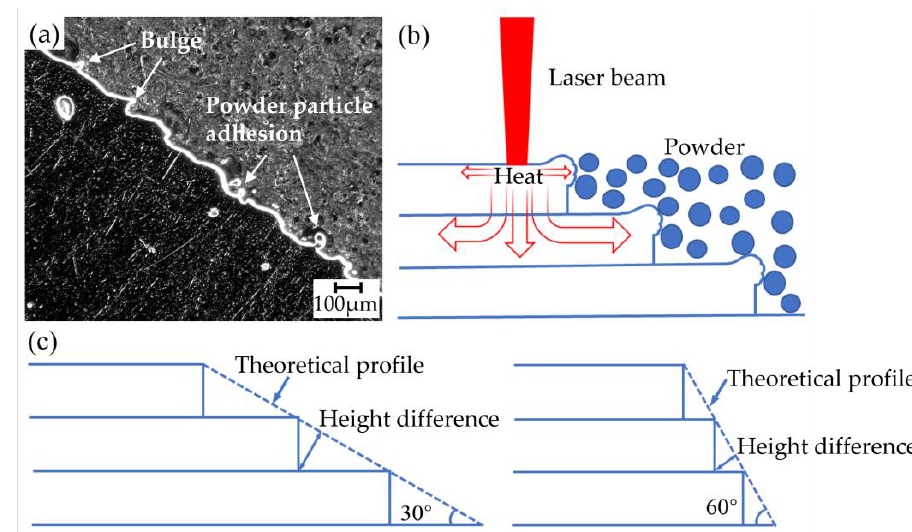
Figure 10. Typical morphology and principle of the upper side during SLM: ( a ) section diagram; ( b ) schematic diagram of thermal diffusion; ( c ) step effect.